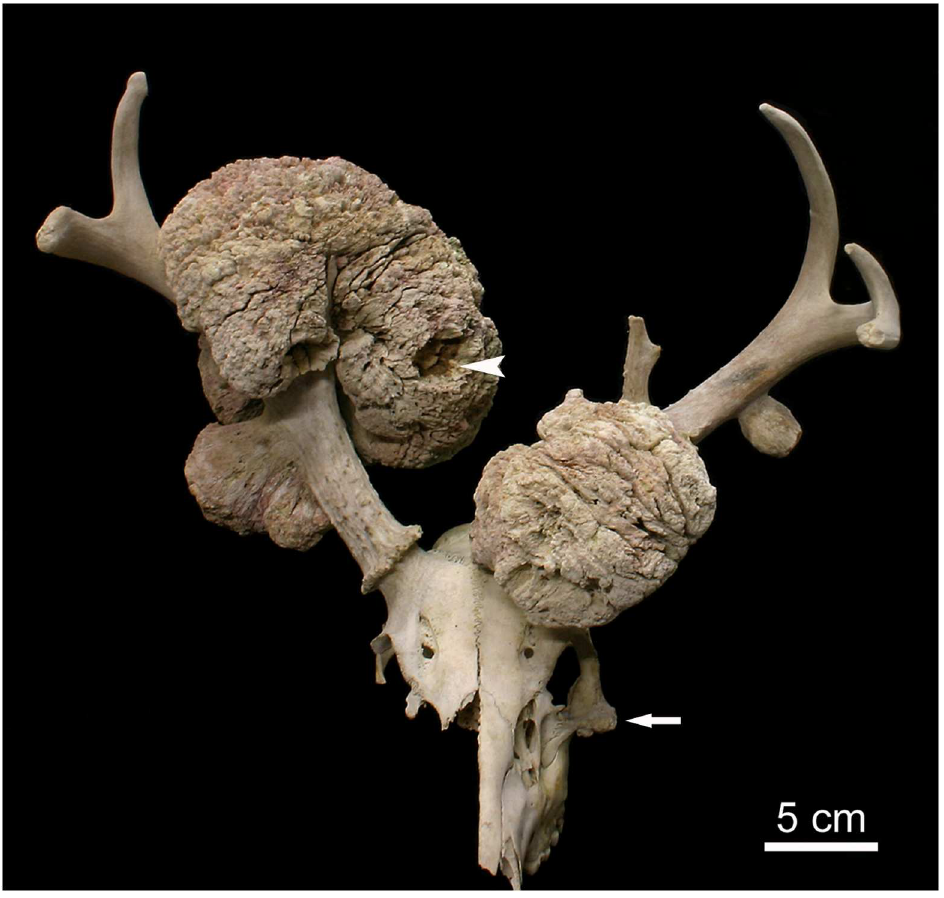
Fig 1. Antlered cranium of the white-tailed buck ( Odocoileus virginianus ), rostro-dorsal view. The antlers exhibit severalpedunculatedexostoses of different size. The surface of these exostoses is rugose and characterized by crevices and some deep crater-like depressions (arrowhead). Arrow: small, sessile exostosis on the left zygomatic